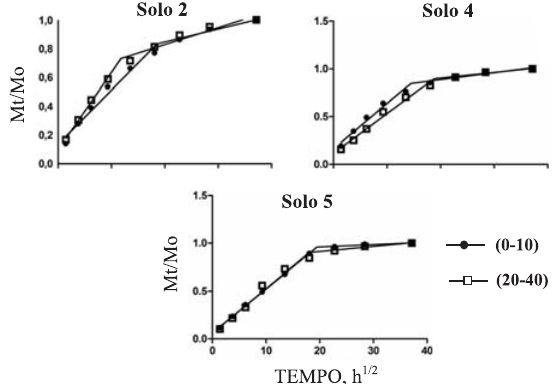
Figura 2. Cinética de liberação de Pb [equação parabólica de difusão (Mt/Mo = a + kt 1/2 )] das amostras de solos contaminadas com rejeito de metalurgia, em área localizada no município de